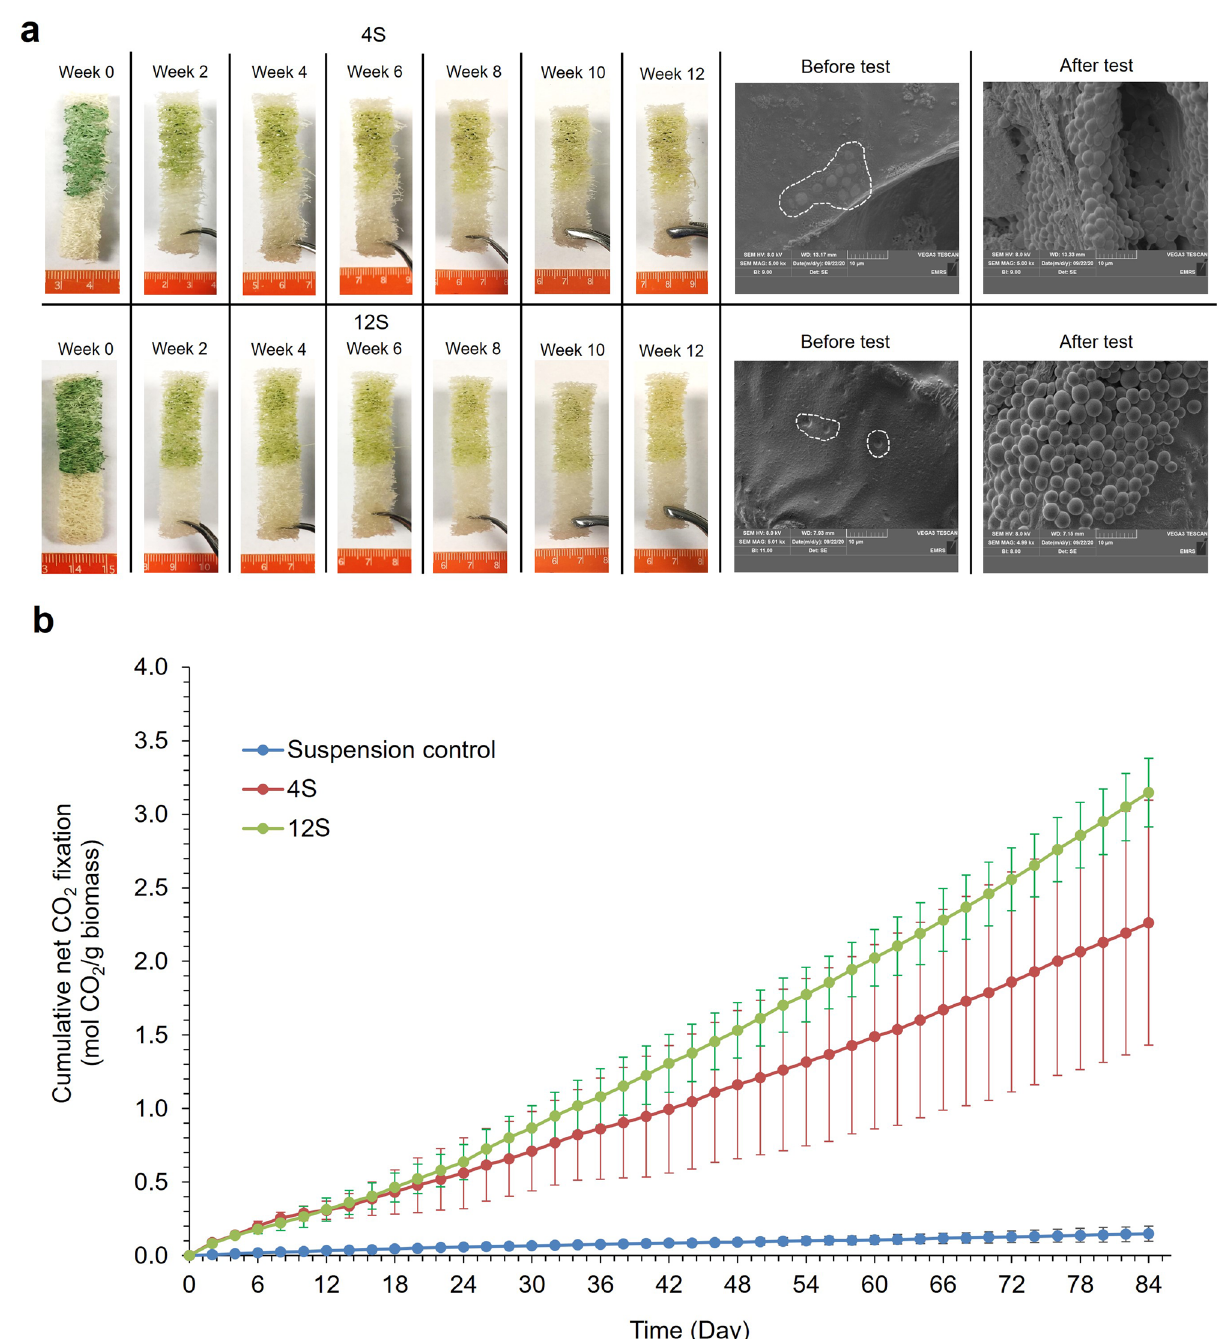
Figure 6. Semi-batch CO 2 absorption tests with Synechococcus elongatus CCAP 1479/1A biocomposites with the 4 N and 12 N latexes. ( a ) Images demonstrate cell release and pigment bleaching as well as SEM images of biocomposites before and after tests. White dash lines indicate where cells were deposited on the biocomposites. ( b ) cumulative net CO 2 absorption over the twelve weeks period. ‘Soft’ (S) latex had a styrene to butyl acrylate ratio of 1:1. The preceding number in the latex code corresponds to the Texanol content. (Mean ± StDev; n =